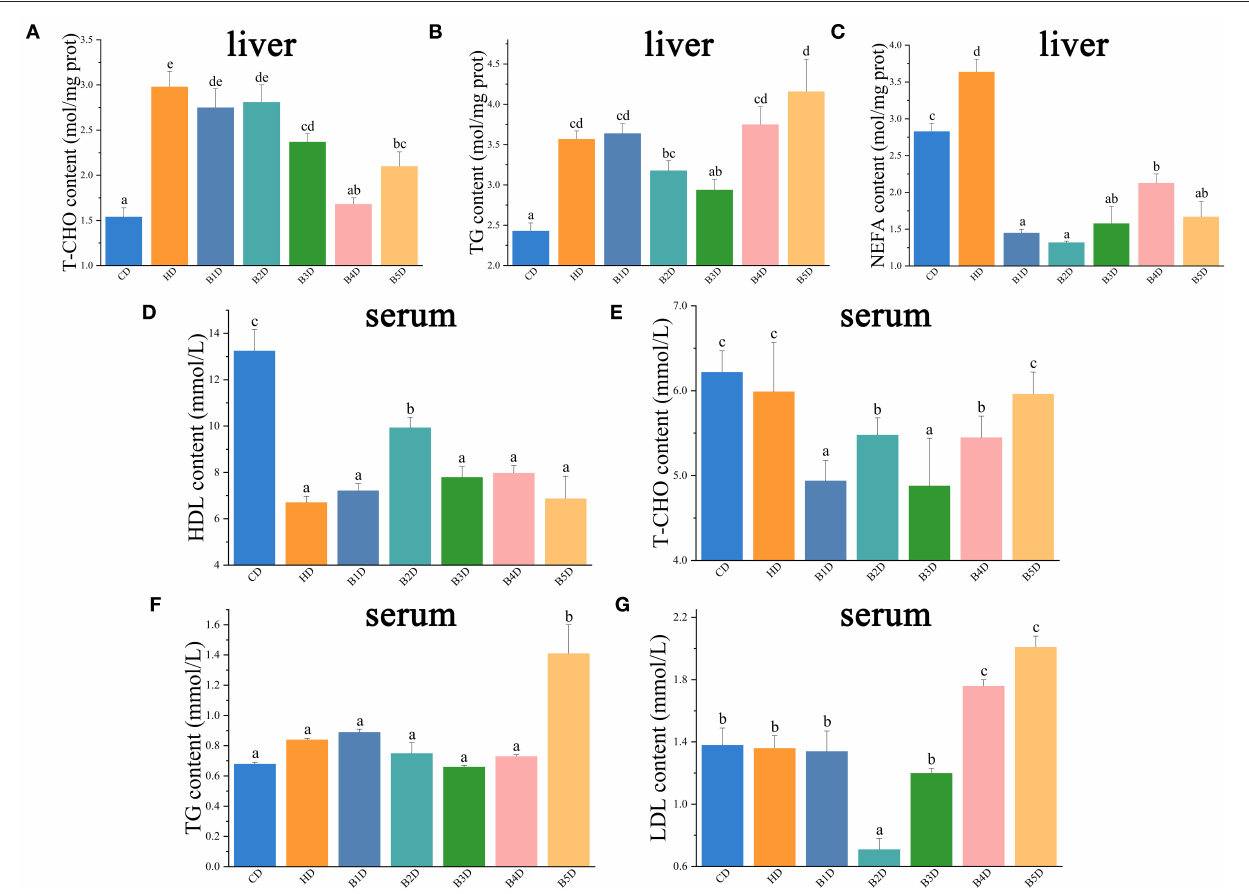
FIGURE 3 | Biochemical indicators in liver and plasma of hybrid groupers from HD and BD groups. (A – C) the contents of T-CHO (total cholesterol), TG (triglycerides), and NEFA (non-esterified fatty acid) in the liver ( n = 6). (D – G) the contents of HDL (high-density lipoprotein cholesterol), T-CHO, TG and LDL (low-density lipoprotein cholesterol) in serum ( n = 6). Values are presented as means with SD, where significant ( p < 0.05) differences between groups are indicated by different letters.